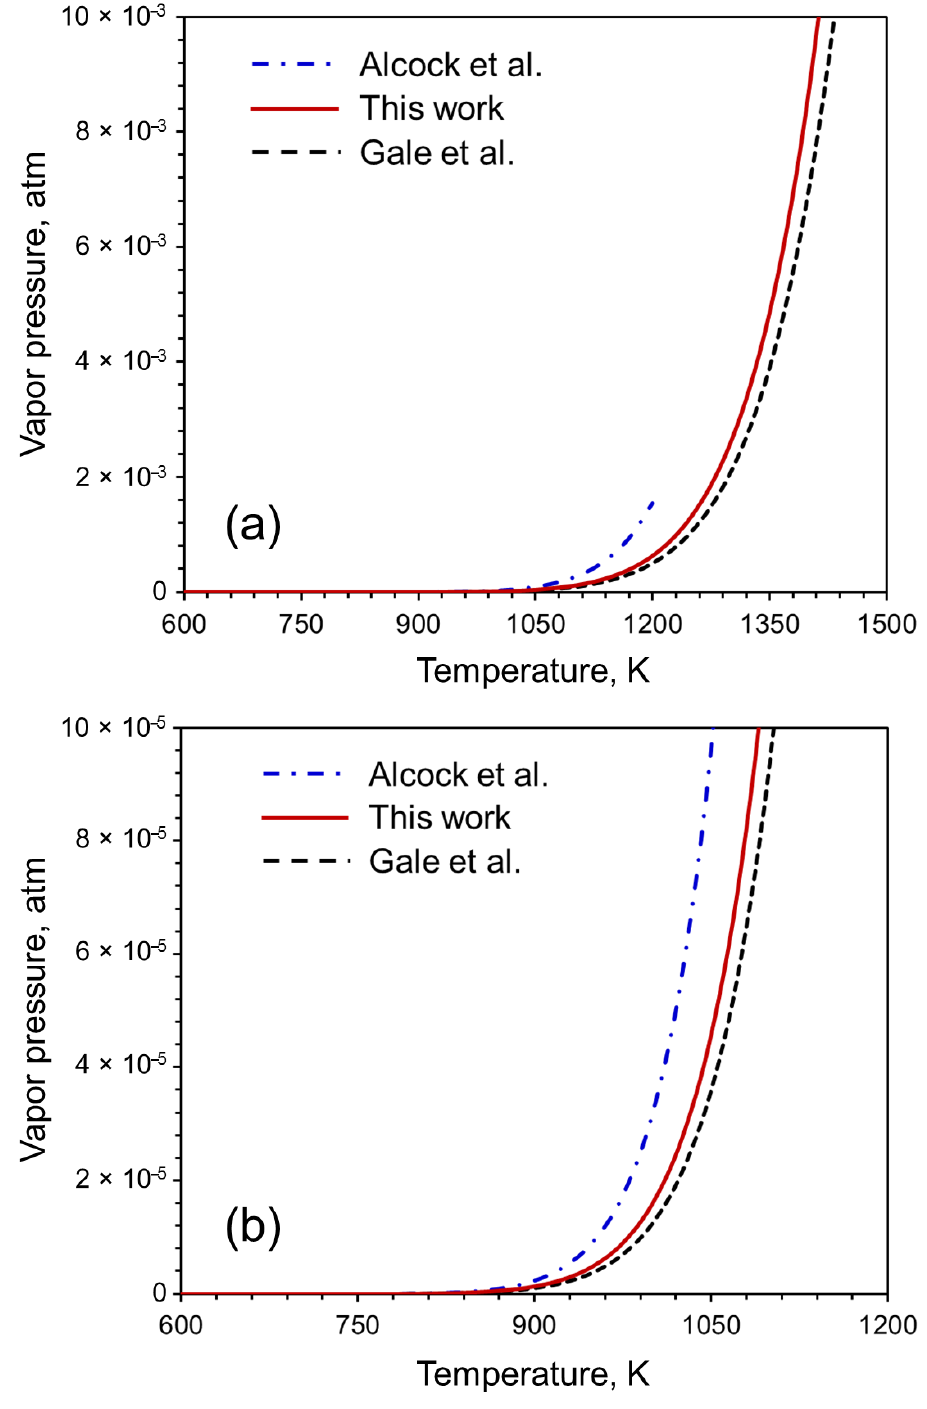
Figure 8. ( a ) Evaluation of reliability of the proposed equation for calculating vapor pressure. Figure 4. This is a wide figure.